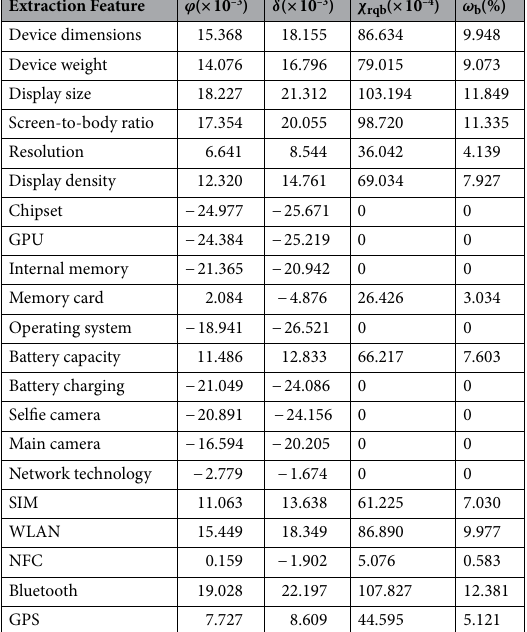
Table 3. The values of ϕ , δ , χ rqb , and ω b of each extracted feature.